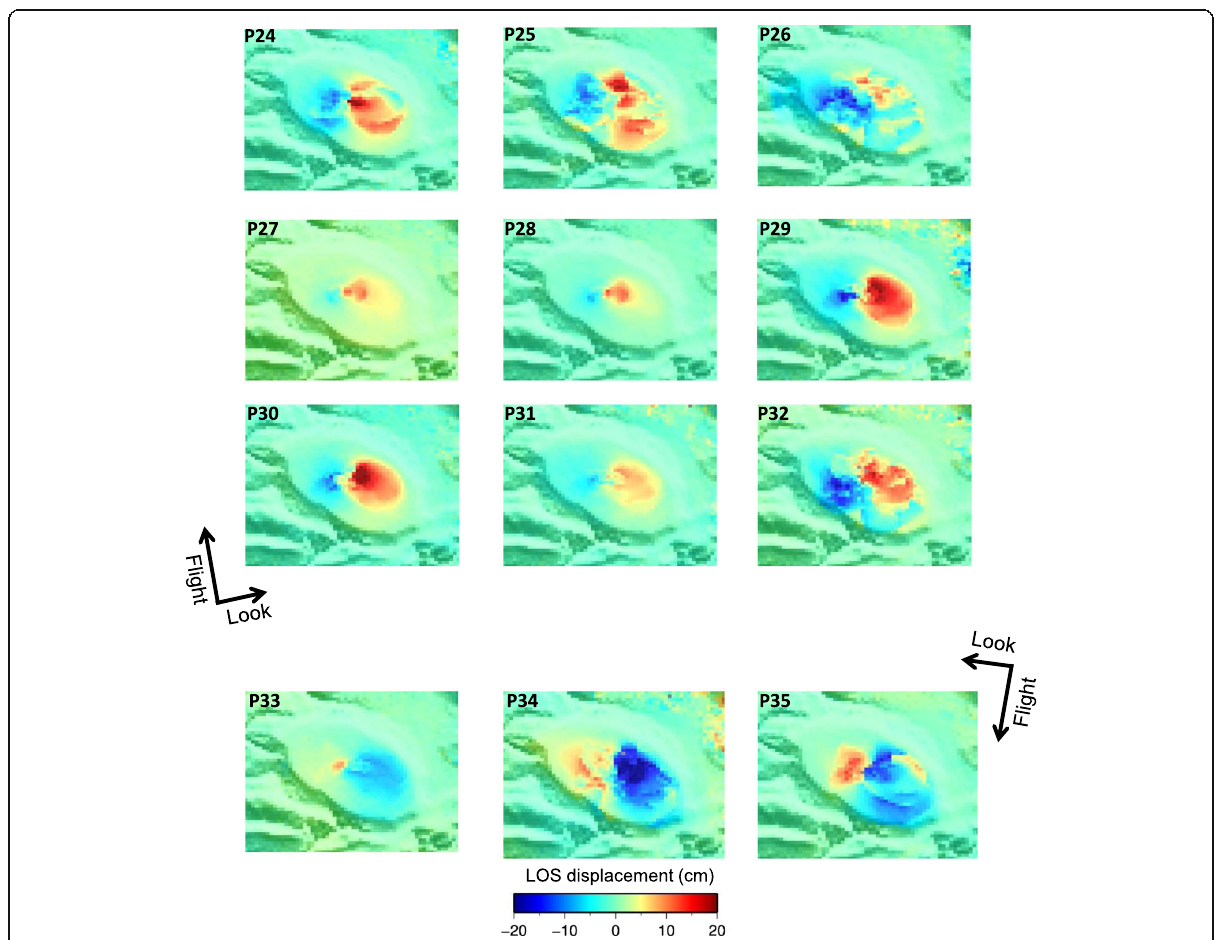
Fig. 4 Observed unwrapped InSAR images derived from ALOS-2/PALSAR-2 ascending track data (path 176, frame 800, P24 – 32) and descending track data (path 71, frame 2800, P33 – 35). Details of each data set are described in Table